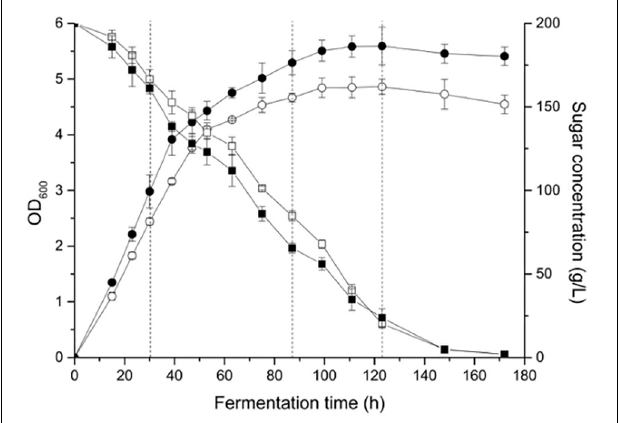
FIGURE 1 | Cell growth and sugar concentration profiles during the fermentation of MS 300 media with high ( ) UFA concentrations. Data points represent the mean value from triplicate fermentations, and the vertical bars show ± SD. Dashed lines represent the three growth phases in which the microarray analyses were